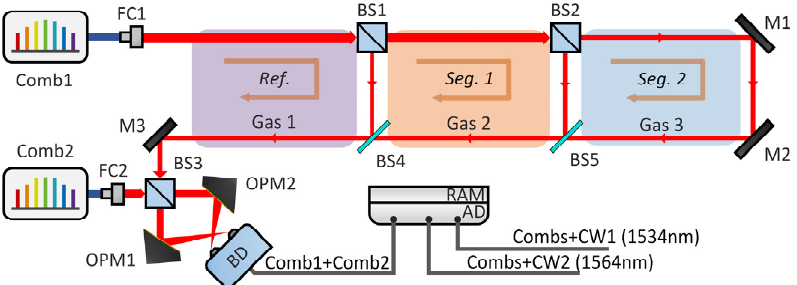
Figure 3. Experimental setup of the gas distribution measurement scheme. AD, analog to digital converter. BD, balance detector. BS1, BS2, BS3, cube beam splitter. BS4, BS5, pellicle beam splitter. Comb1, Comb2, optical frequency comb. CW1, CW2, continuous wave laser. FC1, FC2, fiber collimator. M1, M2, M3, mirror. OPM1, OPM2, off-axis parabolic mirror. RAM, random-access memory. Red line, space light. Blue line, fiber. Grey line, cable. Ref., reference path. Seg.1, Seg.2, different segments of the target path.